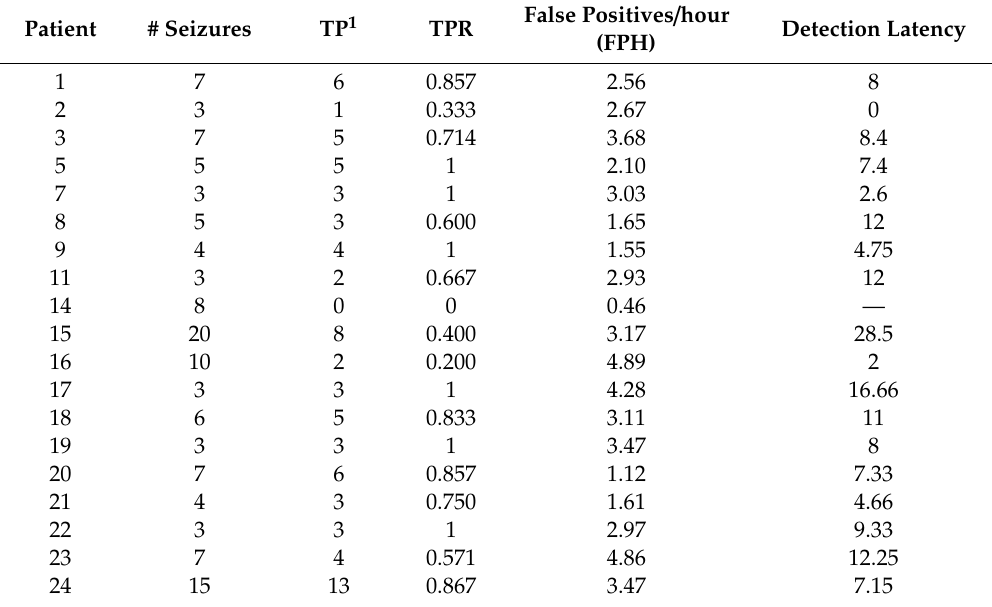
Table 3. CHB-MIT